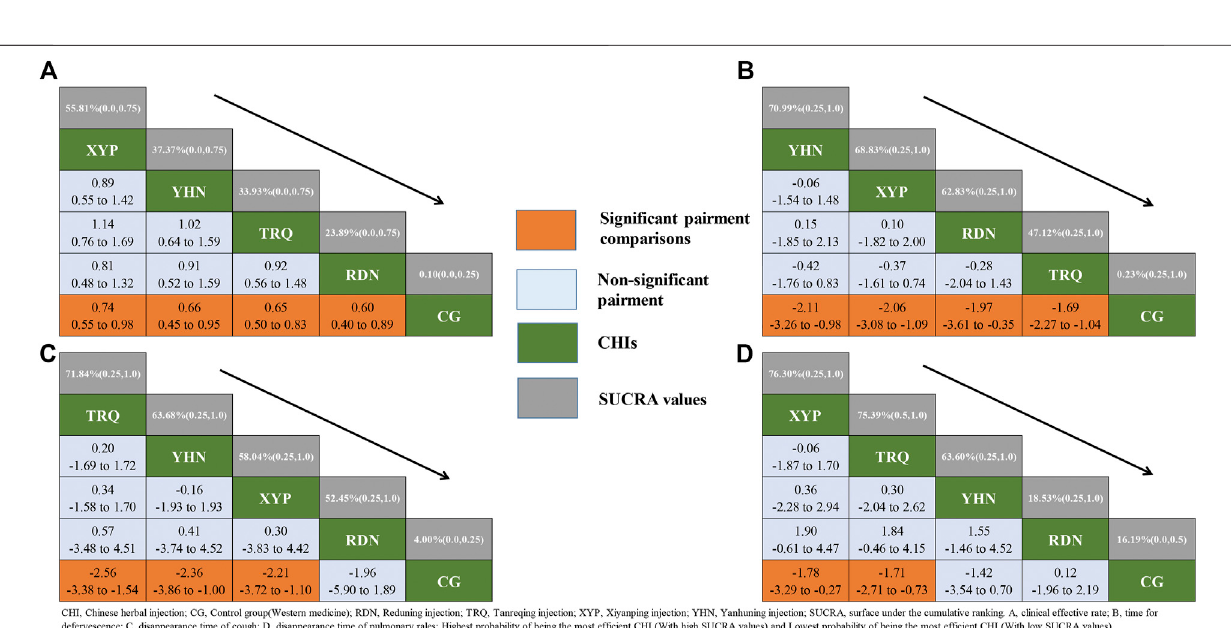
Frontiers in Pharmacology |